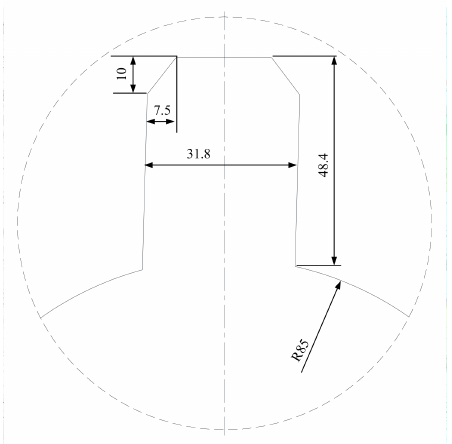
Figure 6. The designed stator slot dimensions in mm.